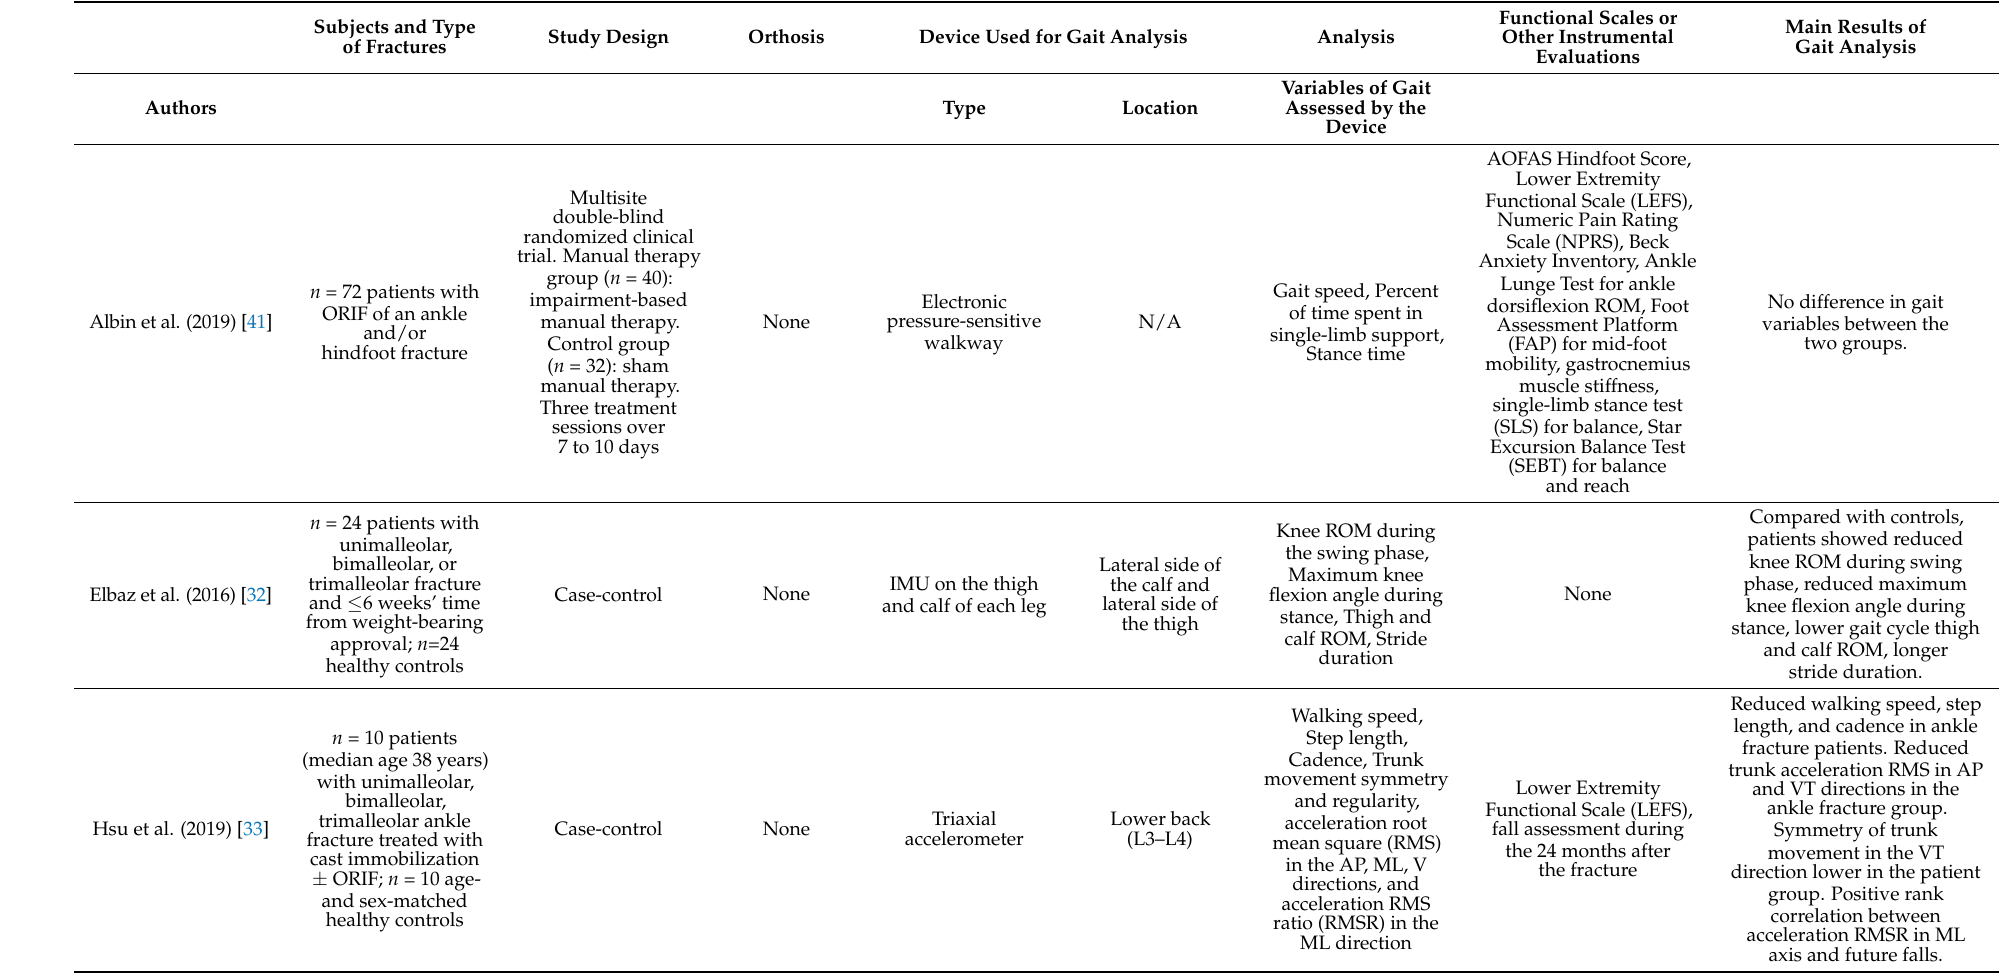
Table 3. Summary of the main information extracted from the selected